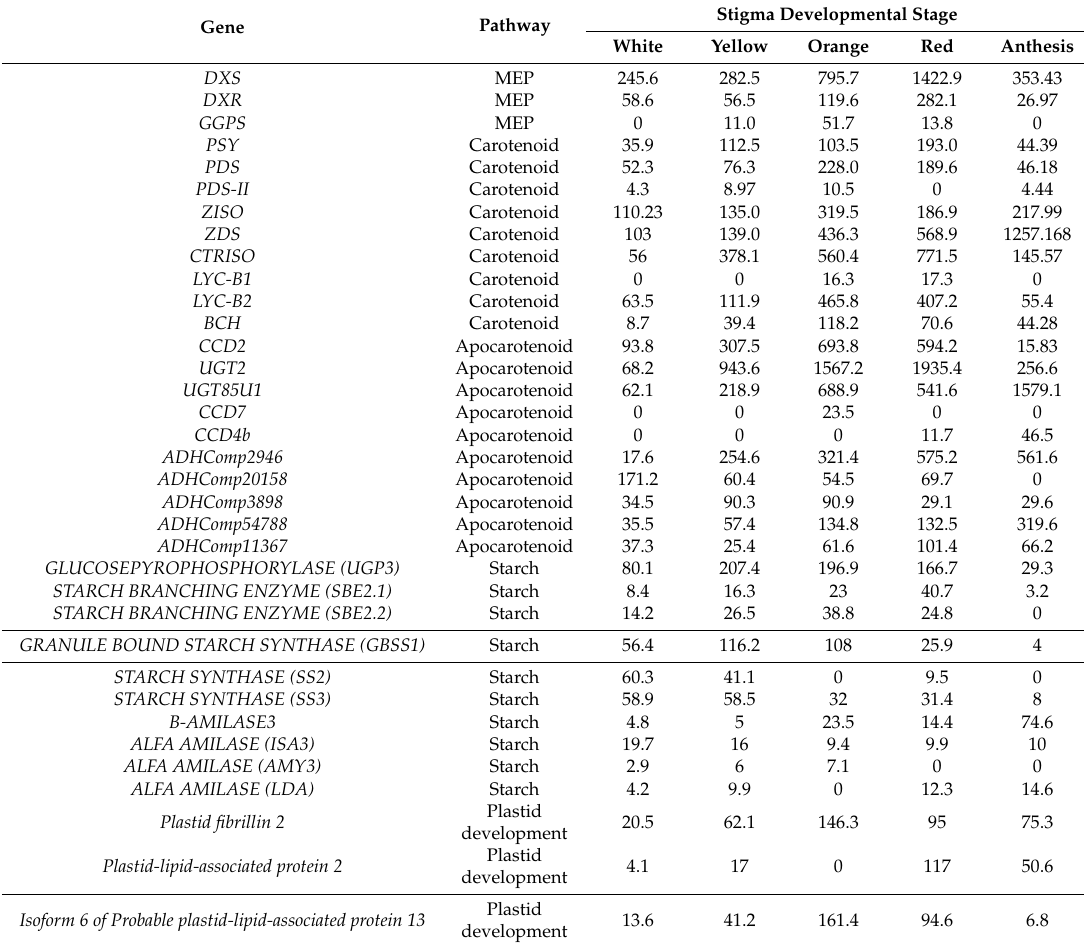
Table 3. Transcript levels of genes involved in carotenoid pathway, and Plastid-lipid-associated proteins, at five different stages of stigma development. For more details, see materials and methods. Stigma Developmental Stage Gene Pathway White Yellow Orange